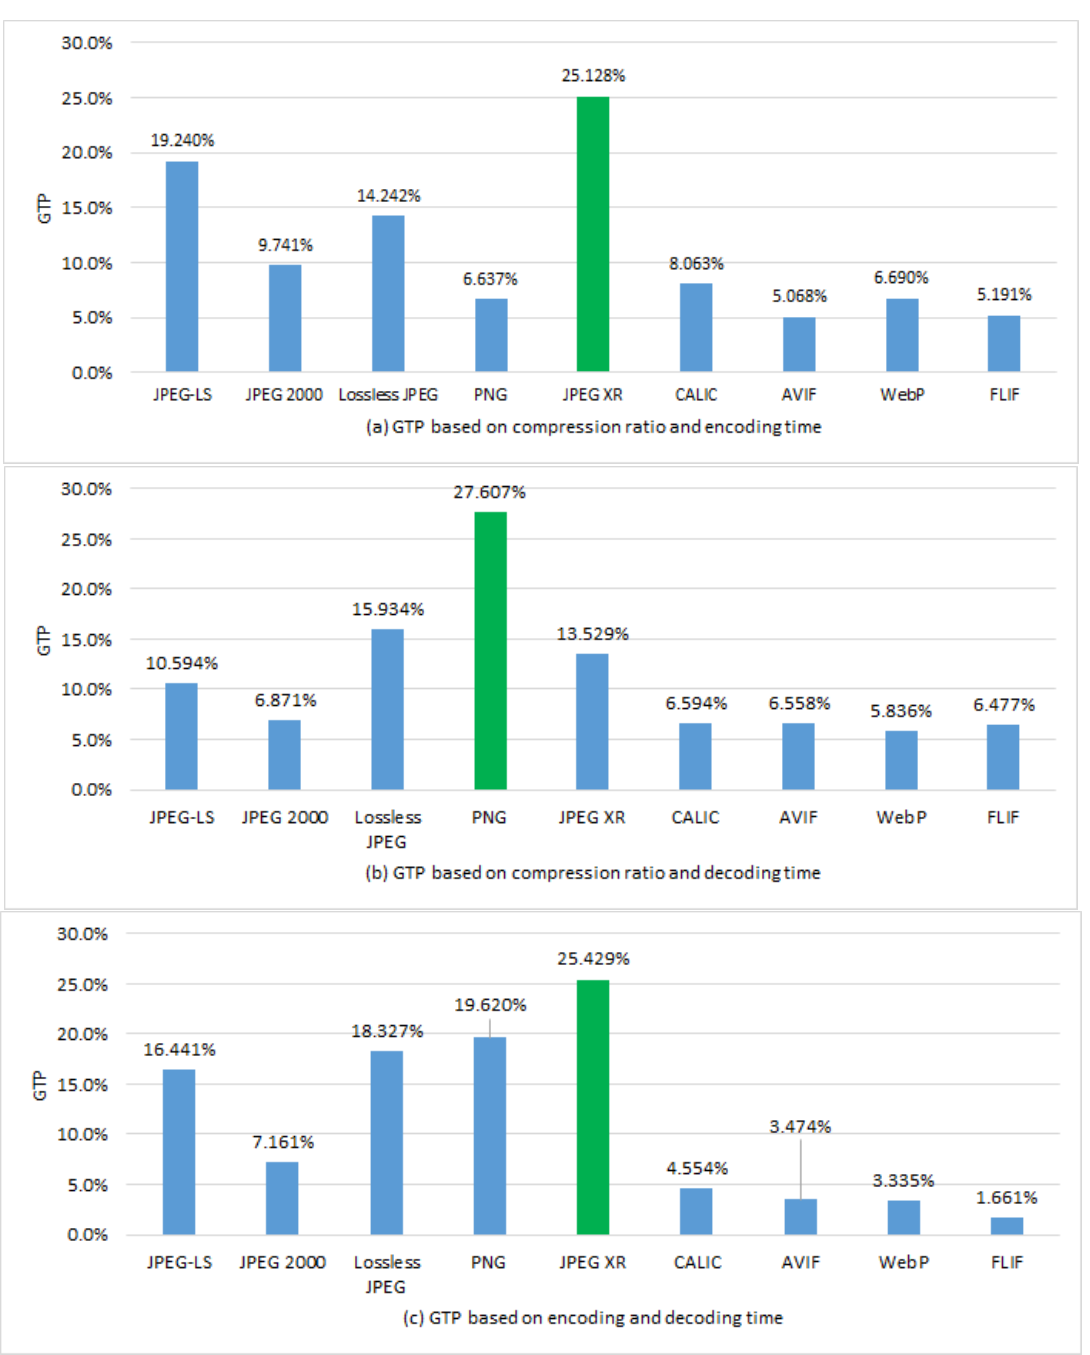
Figure 29. Two-parameter grand total performance (GTP) for 8-bit greyscale